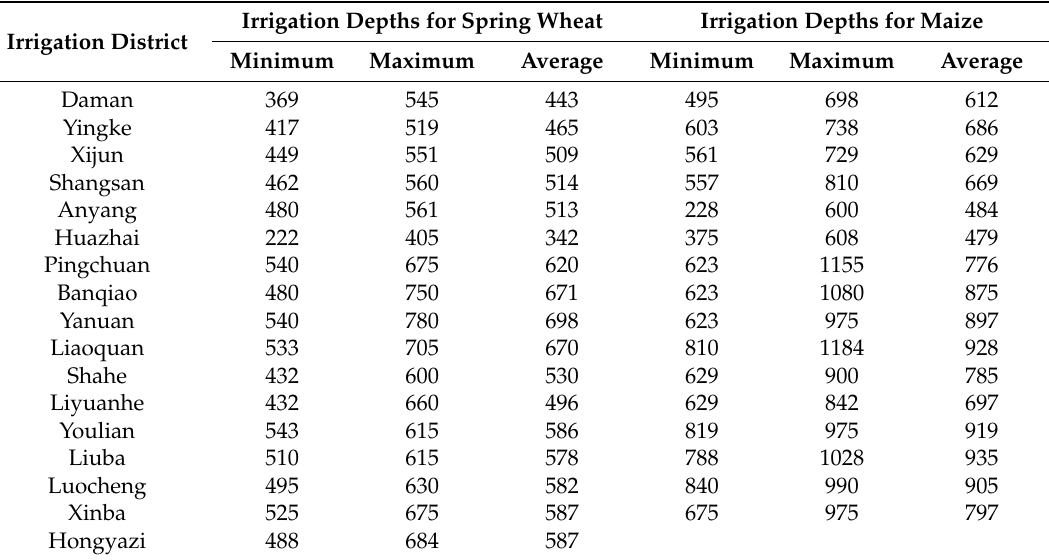
Table 2. Basic statistics of irrigation depths for the main crops in different irrigation districts (unit: mm).